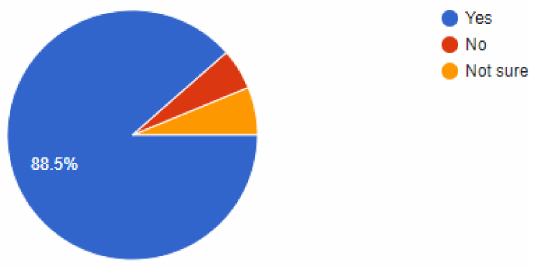
Figure 5. Dentists in agreement to wear PPE and